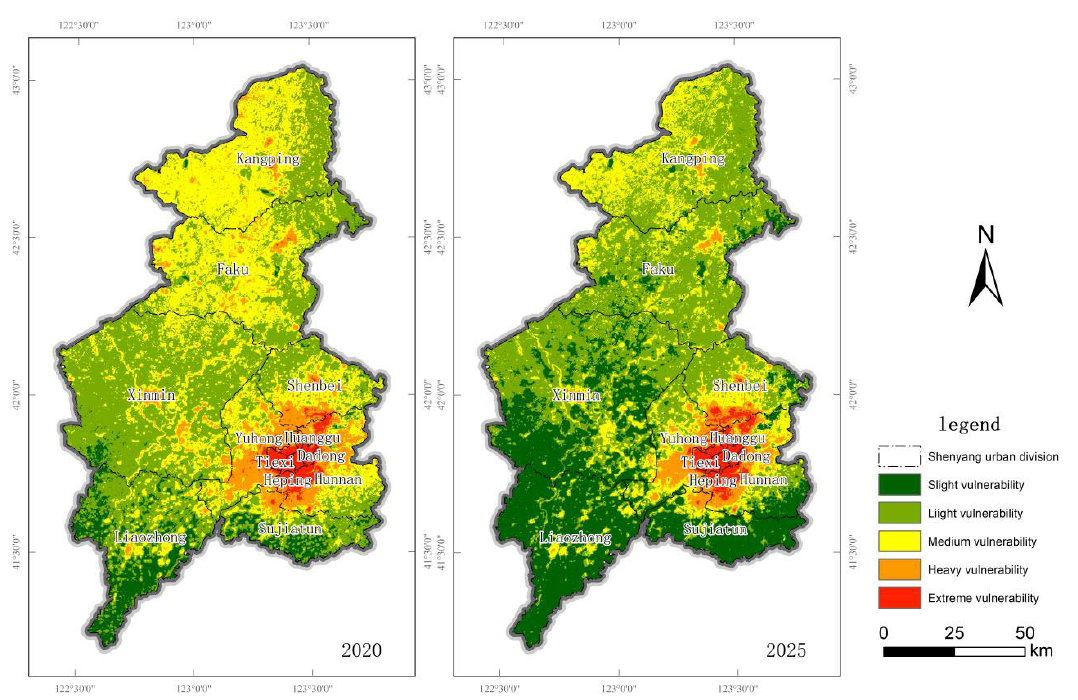
Figure 9. Simulation results of ecological vulnerability in Shenyang in 2020 and 2025. Table 7. Changes of ecological vulnerability in Shenyang in 2020 and 2025 (km 2 ).